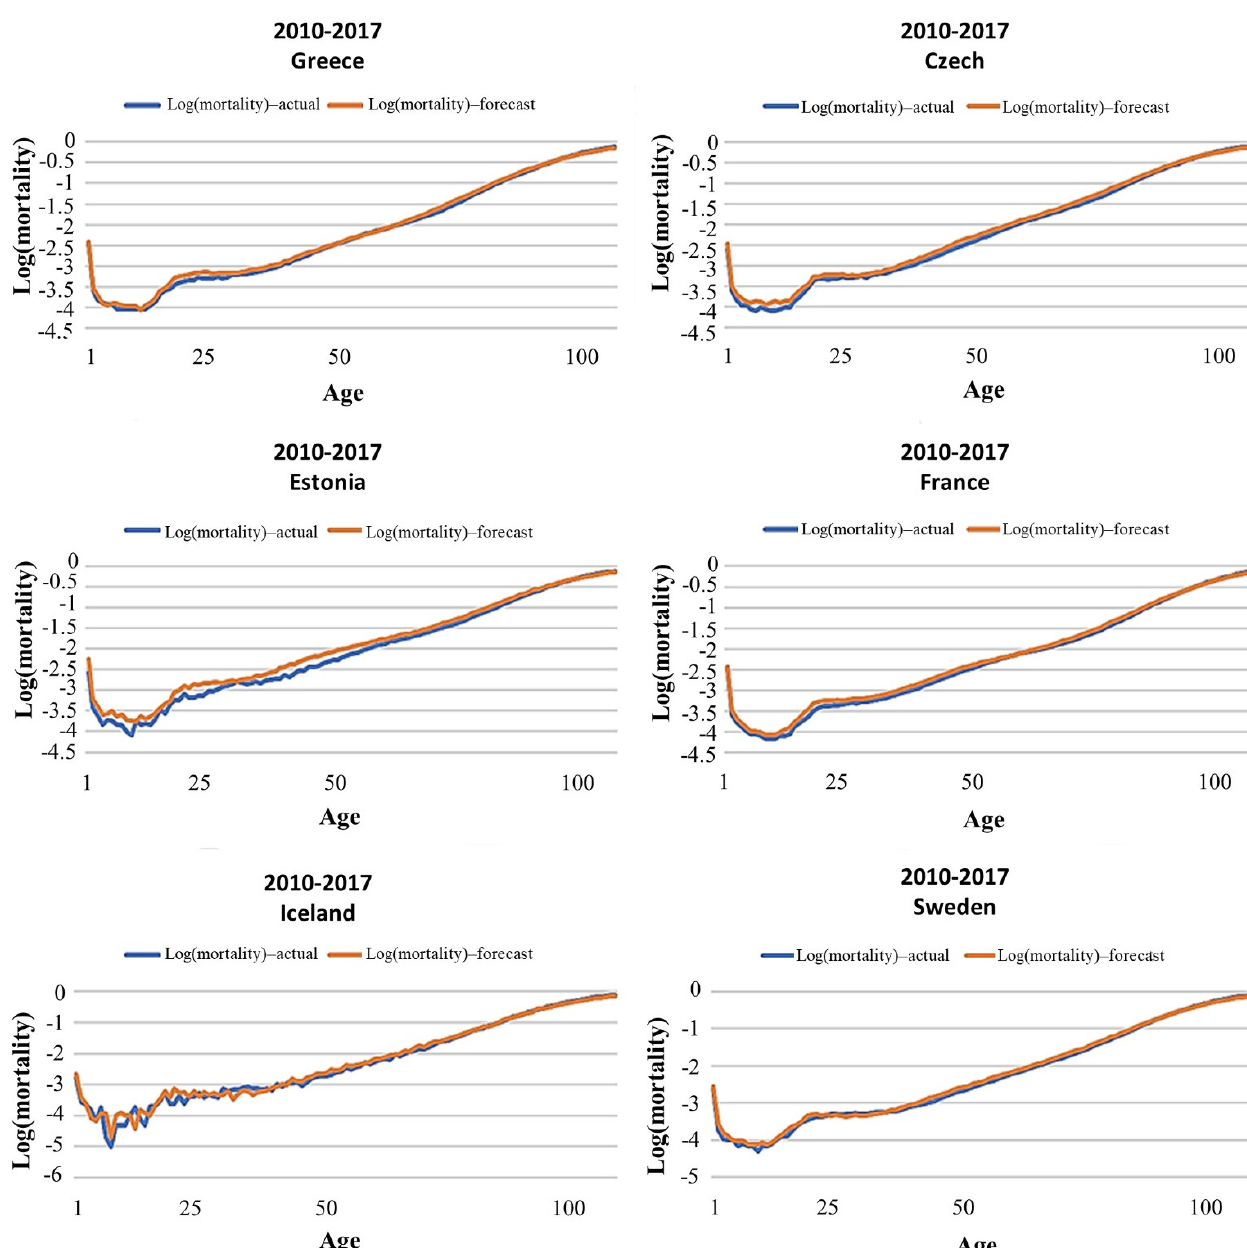
Figure 6. Approach to the projection of mortality (red) in the real (blue) data indicative for the countries of Greece, the Czech Republic, Estonia, France, Iceland and Sweden, for the years 2010–2017.